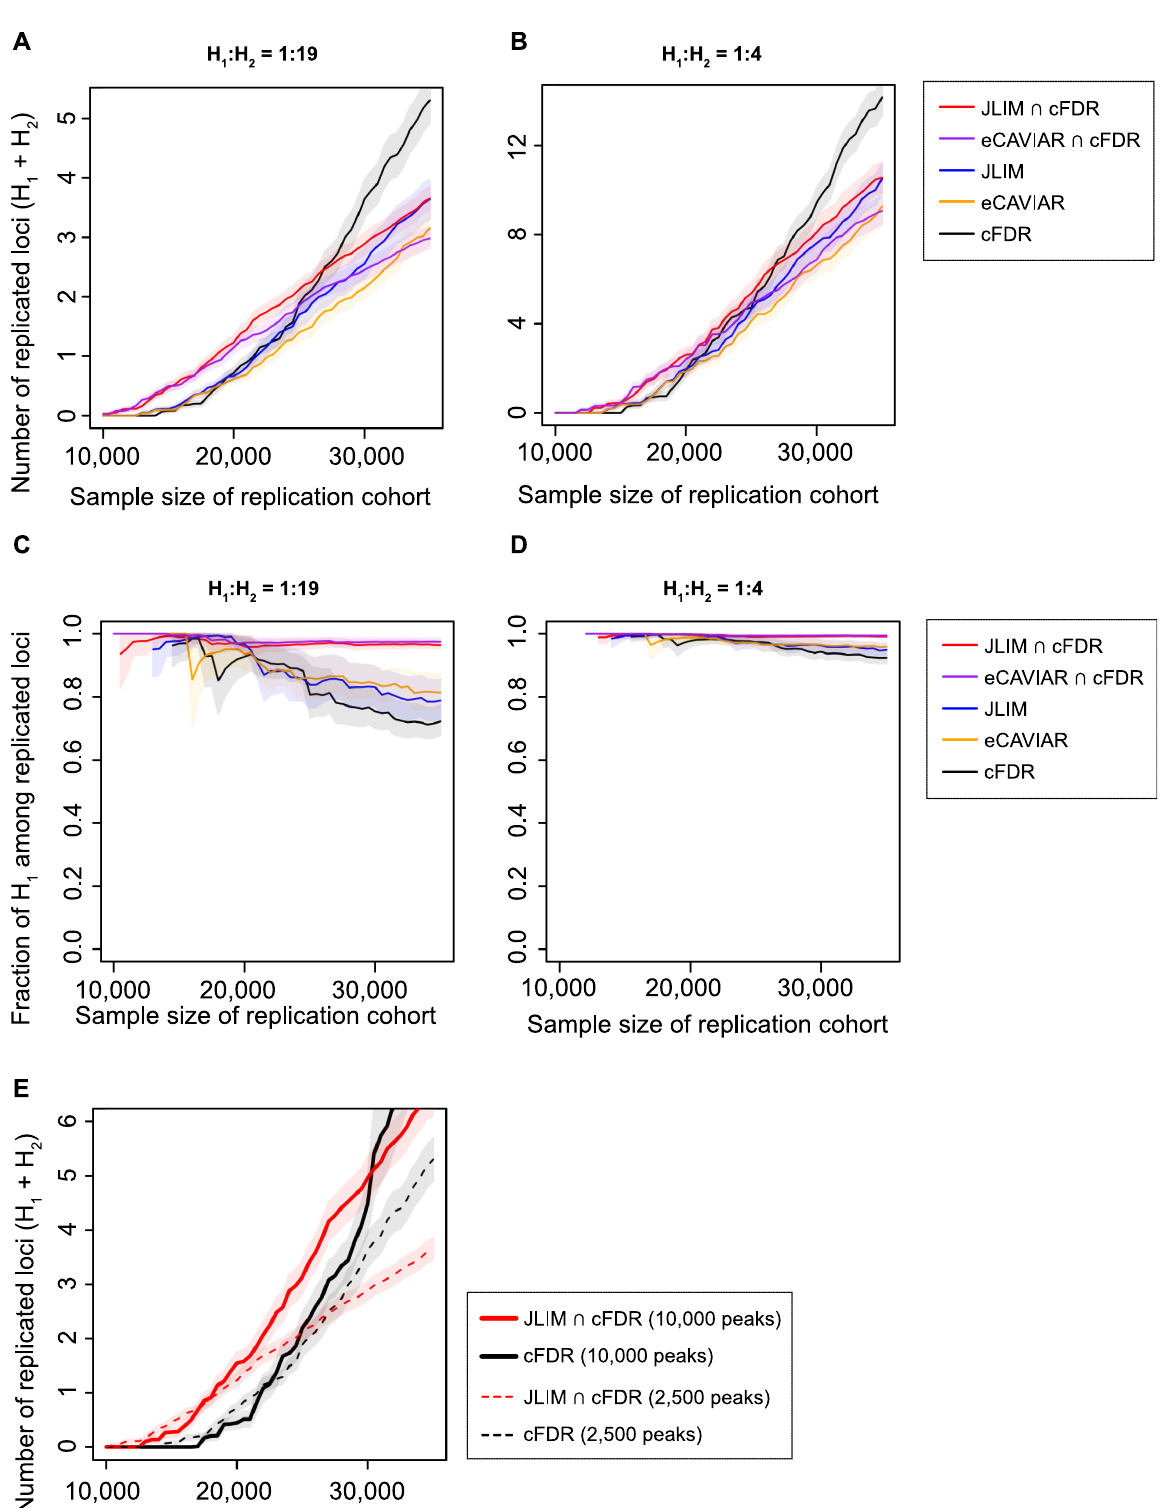
Fig 1. The projected number of replicated loci and proportion of shared causative variants among the replicated loci. A total of 2,500 association peaks from well-powered GWAS studies (n = 150,000) were tested for the shared effect in simulated discovery cohorts (n = 10,000),